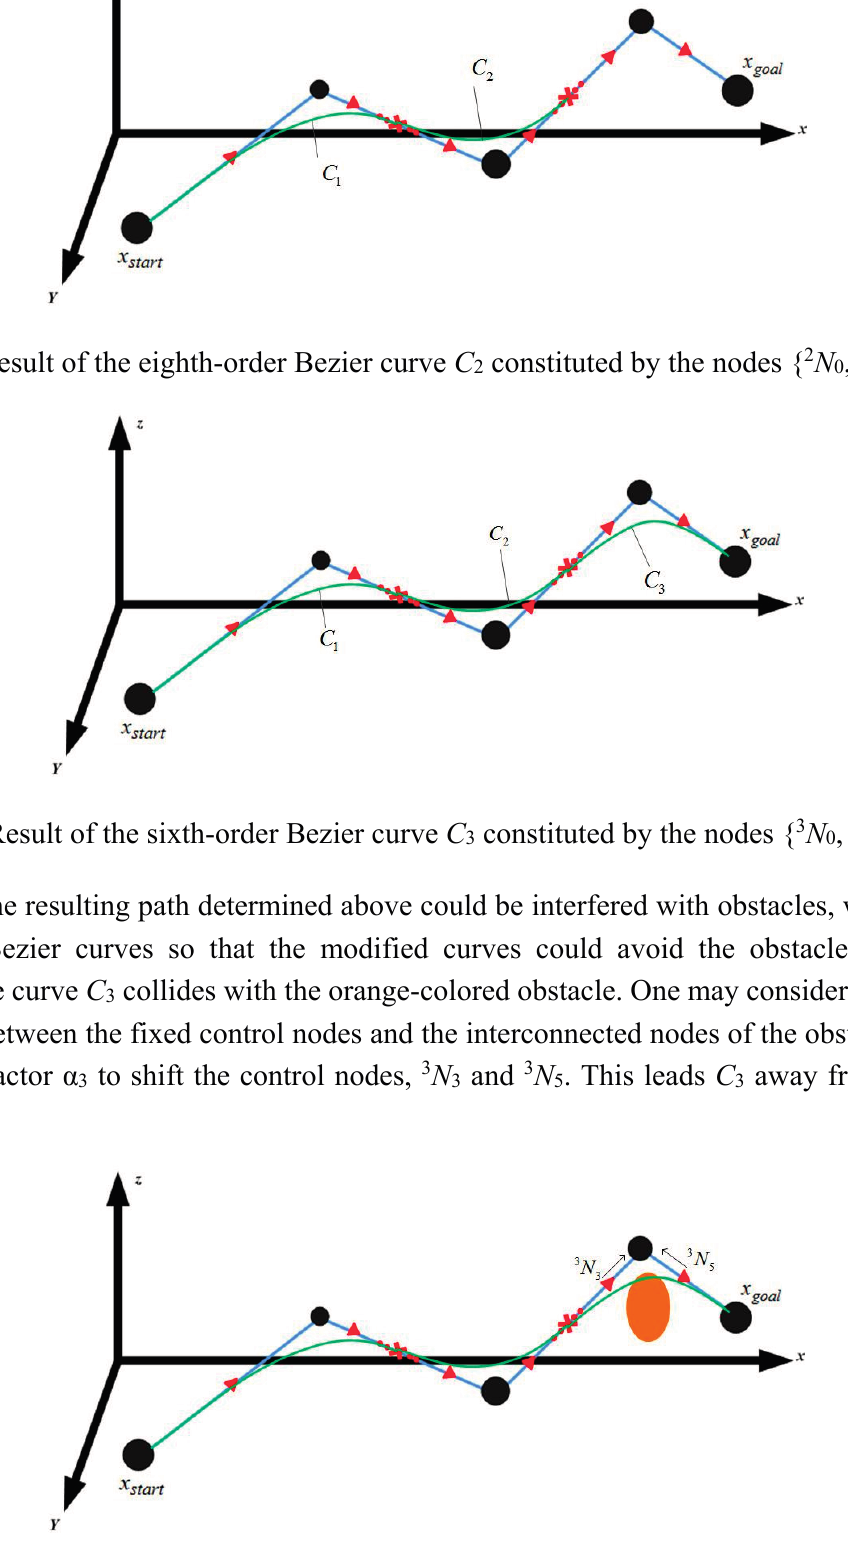
Figure 10. C 3 collides with the